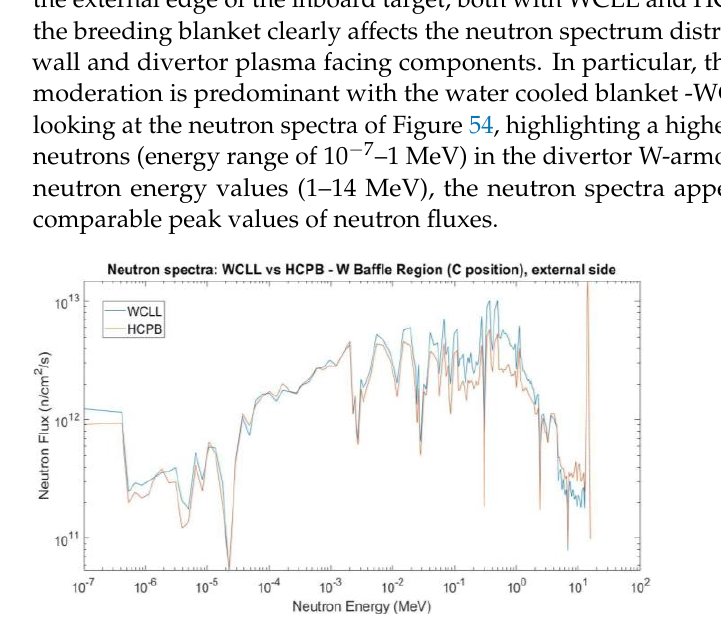
Figure 54. Comparison between the neutron spectra impinging on the W-Monoblock placed on the baffle region of the inboard target (position C, see Figures 7 and 9) at the external side, with WCLL and HCPB.